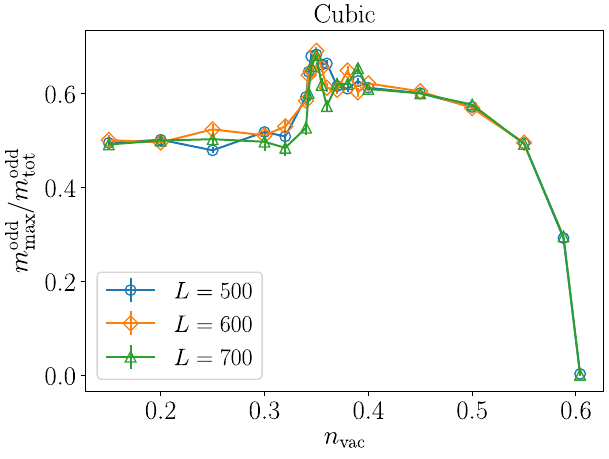
FIG. 18. On the cubic lattice, the largest, odd R -type region contains a nonzero fraction of the total mass in such odd regions ≈ 0 . 6 in the thermodynamic limit, below a threshold value of n vac as is clear from the displayed results for the sample average of this fraction. This may be compared with results discussed in Sec.